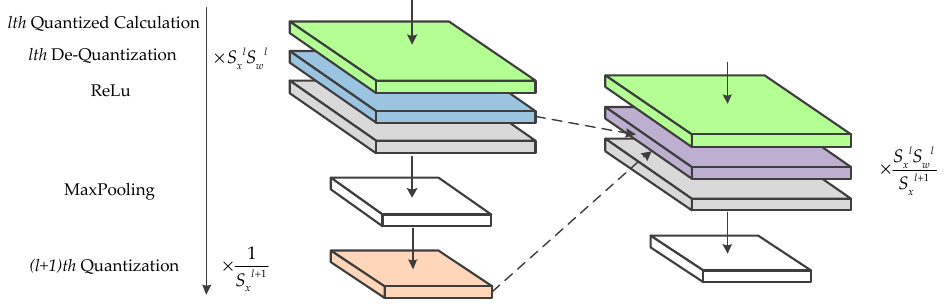
Figure 5. Fusing floating-point multiplication for the optimization to hardware